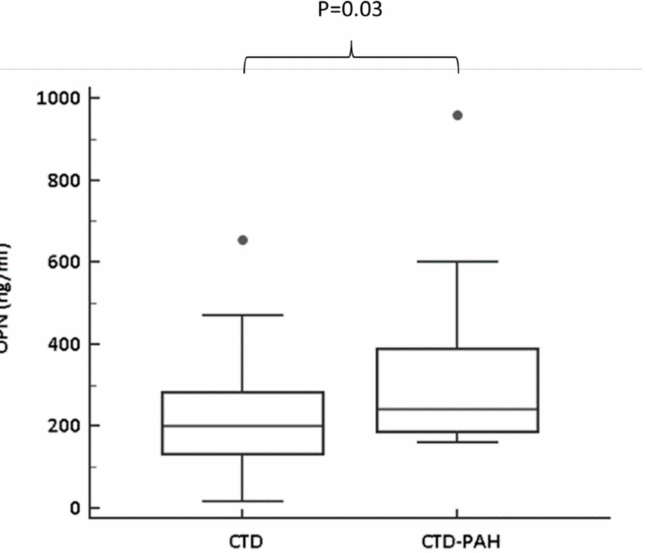
Figure 1. Plasma osteopontin (OPN) levels in CTD and CTD-associated pulmonary arterial hy- pertension (CTD-PAH) patients. As shown in the figure, CTD-PAH patients showed higher OPN plasma levels.